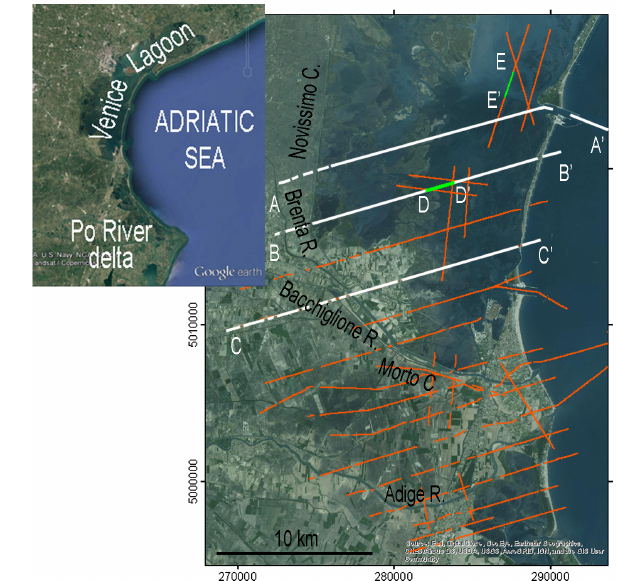
Figure 1. Satellite images of the southern Venice Lagoon – north- ern Po River Delta coastland. Red and white lines show the AEM acquisition